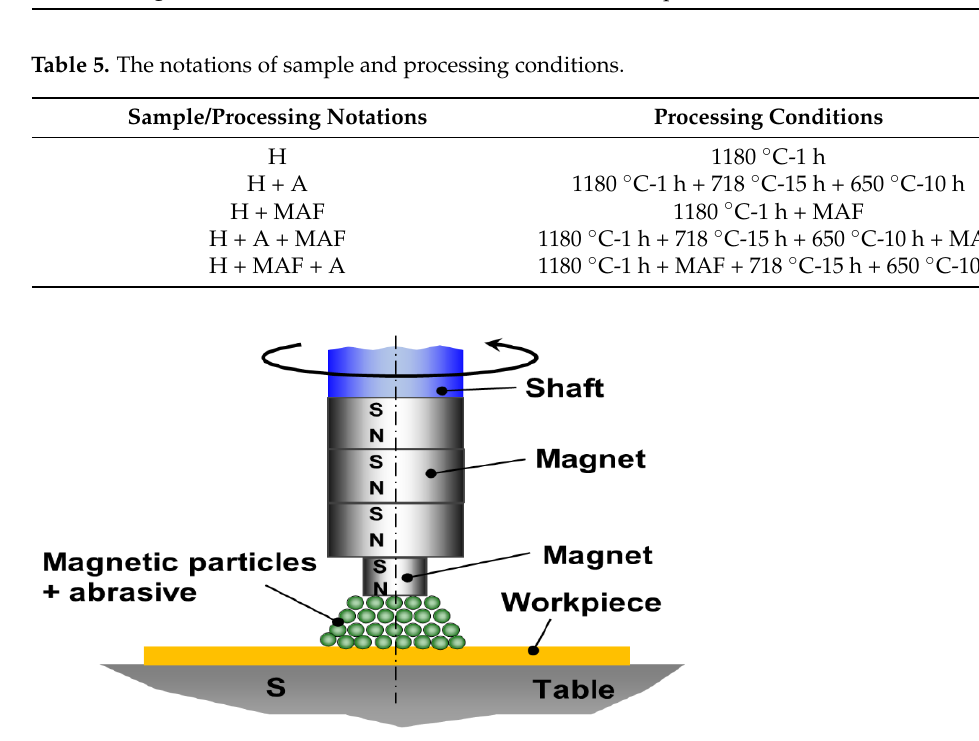
Figure 1. MAF processing principle.